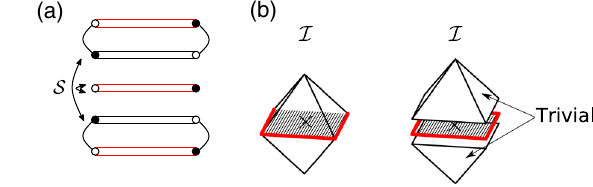
FIG. 9. (a) Dimerization of a stacked-layer system that locally breaks S (anti)symmetry, while preserving S globally. (b) After breaking the local inversion symmetry, the upper and the lower halves of three-dimensional second-order Chern insulator can be trivialized, resulting in a embedded topological